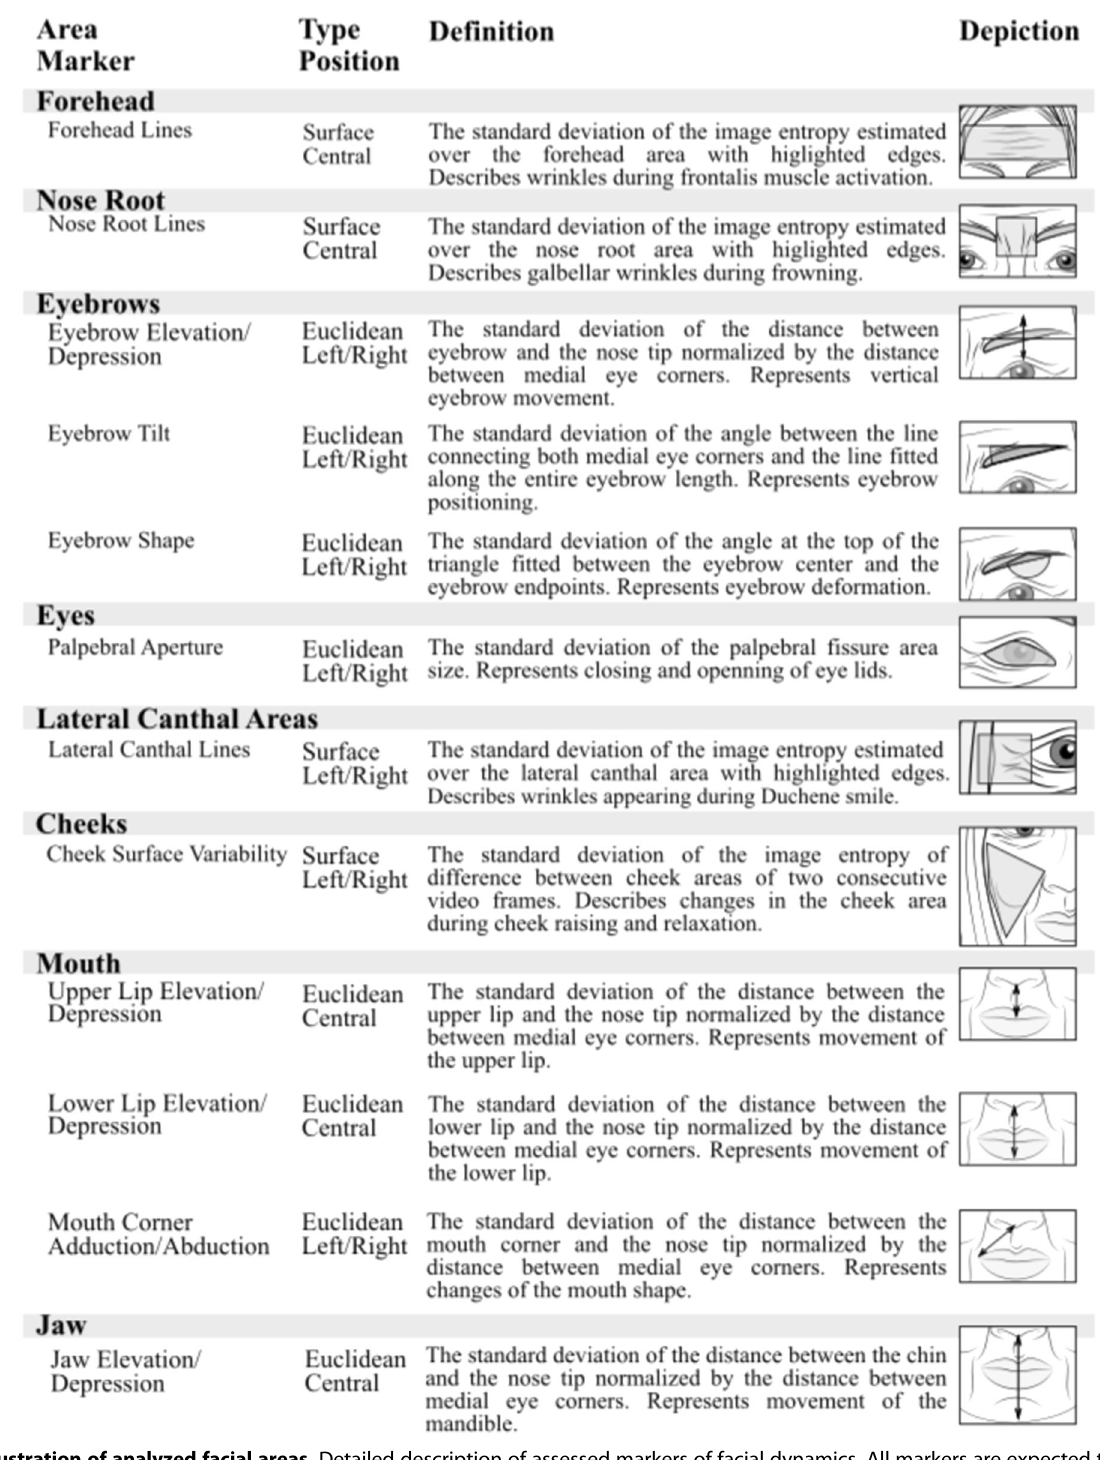
between medial eye corners, represents a movement of the upper lip. The lower lip elevation/depression , de fi ned as the standard deviation of the distance between the lower lip and the nose tip normalized by the distance between medial eye corners, represented a movement of the lower lip. The mouth corner adduction/abduction , de fi ned as the standard deviation of the distance between the mouth corner and the nose tip normalized by the distance between medial eye corners, represented changes in the mouth shape. Finally, the jaw area was described by one Euclidean marker centered